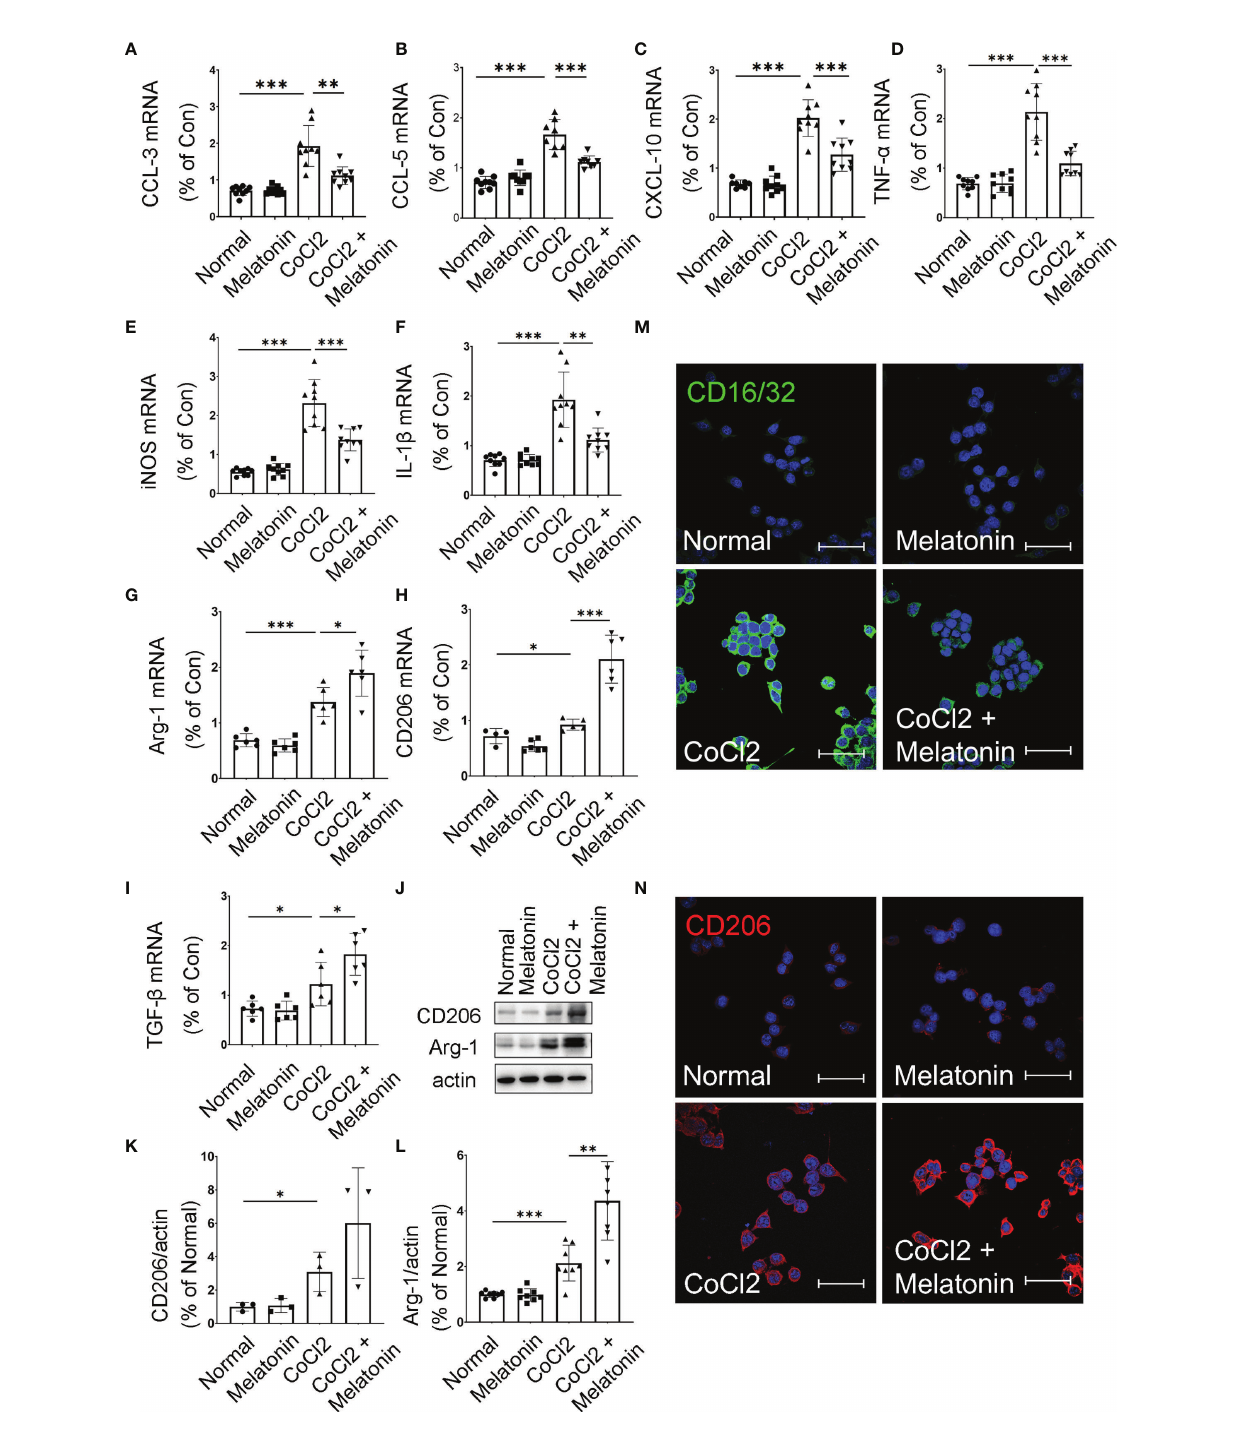
FIGURE 7 | Melatonin regulates microglial activity by balancing pro-in fl ammatory and anti-in fl ammatory mediators. The mRNA expressions of CCL-3 (A) , CCL-5 (B) , CXCL- 10 (C) , TNF- a (D) , iNOS (E) , IL-1 b (F), Arg-1 (G) , CD206 (H) , and TGF- b (I) in the control group, control + melatonin group, CoCl 2 group, and CoCl 2 + melatonin group (n = 6 per group). (J – L) The protein expressions of CD206 and Arg-1 in the control group, control + melatonin group, CoCl 2 group, and CoCl 2 + melatonin group (n = 3 per group). (M, N) Representative images of CD16/32 (green) and CD206 (red) immunostaining in CoCl 2 -treated microglia with or without melatonin. The nuclei were stained with DAPI (blue). Data are expressed as mean ± SEM; *p < 0.05, **p < 0.01, ***p < 0.001 by one-way ANOVA. Scale bar, 40 m